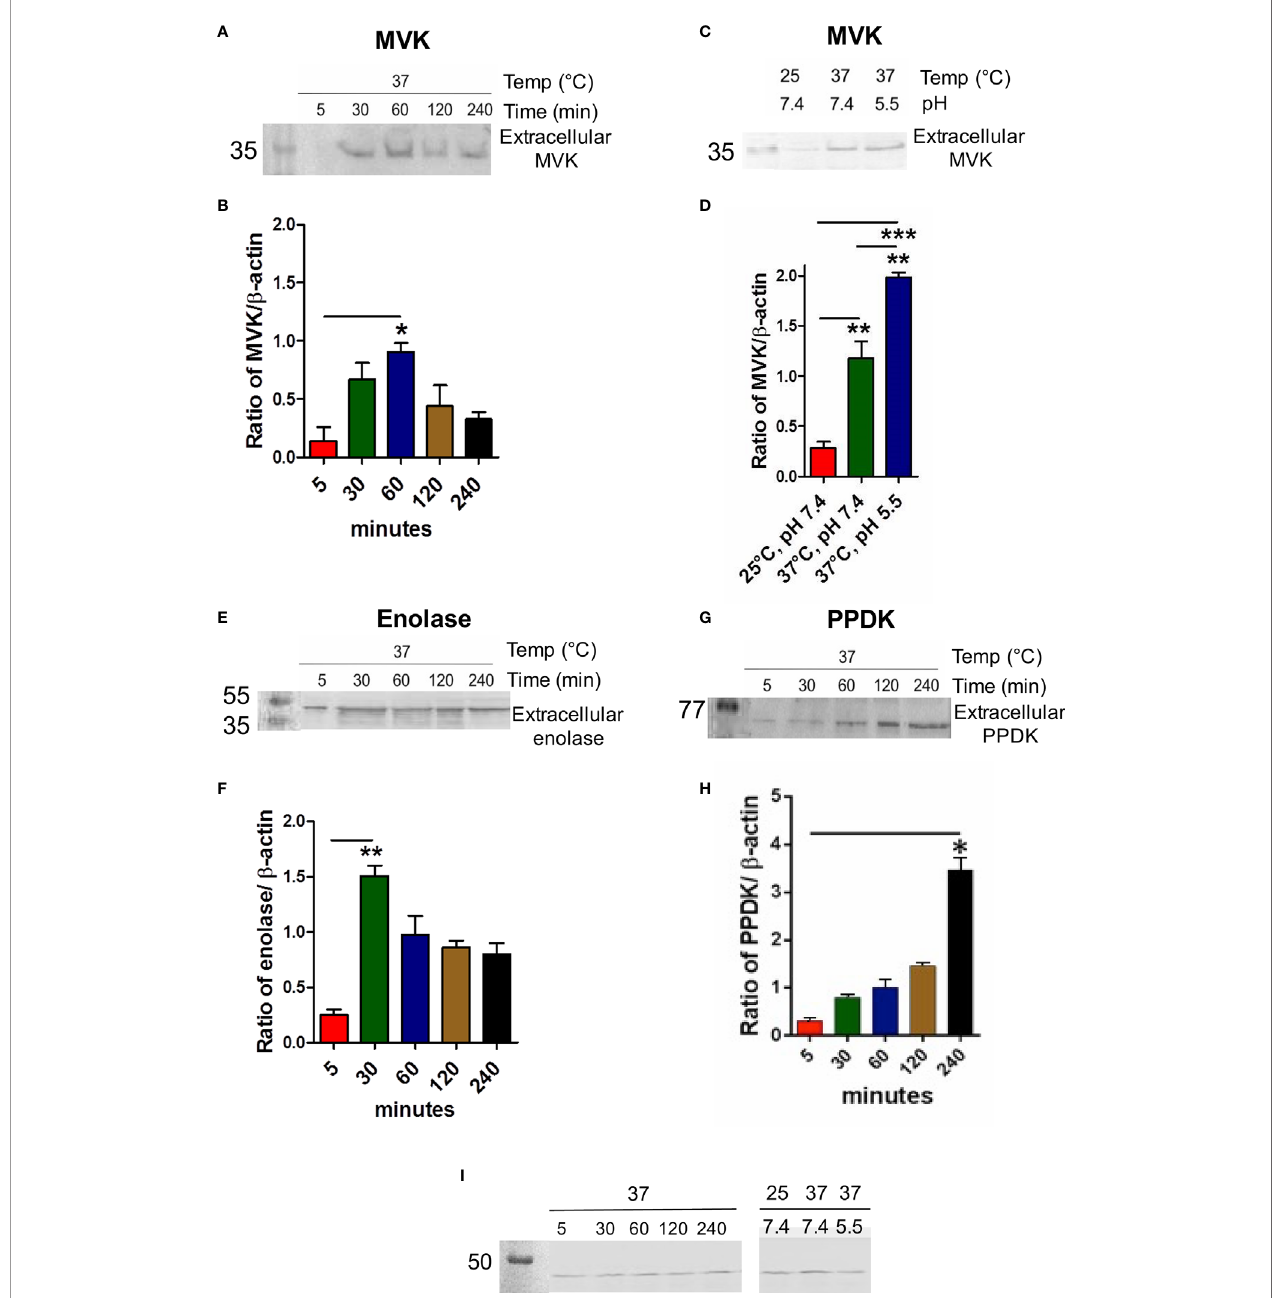
FIGURE 3 | MVK secretion in L. donovani promastigotes is time, temperature, and pH dependent. Western blot of promastigote conditioned medium collected at different time points or different environment conditions and normalized with housekeeping gene ( L. donovani actin). Stationary phase parasites (1 × 10 9 cells) were washed three times in PBS and resuspended in pre-warmed serum free medium to fi nal density of 1 × 10 8 cells/ml. Parasites were stimulated for secretion at 37°C for 5 to 240 min. Conditioned medium consisting of extracellular proteins were probed with anti-MVK antibody (A) , anti-enolase antibody (E) , anti-PPDK antibody (G) , and compared. Parasite lysate for each sample was probed with anti-Ld actin antibody that served as cell number control. Graphical representation of densitometry values of extracellular MVK / intracellular b -actin (B) , extracellular enolase / intracellular b -actin (F) , extracellular PPDK / intracellular b -actin (H) with respect to time. (C) Release of MVK was observed at different temperatures and pH conditions: 25°C and 7.4 pH; 37°C and 7.4 pH; and 37°C and 5.5 pH. Serum- free M199 medium was maintained at different temperatures and pH and parasites were incubated in it for 1 (h) Conditioned medium was obtained, concentrated, and western blot was performed using anti-MVK antibody. (D) Graphical representation of densitometry values of extracellular MVK obtained from different conditions normalized with b -actin. (I) 3% whole cell lysates from all the conditions were probed with anti-actin antibody. Error bars in all graphs represent standard error from three independent experiments performed in triplicates. p value < 0.05 is denoted by *, p value ≤ 0.01 is denoted by ** and p value ≤ 0.001 is denoted by